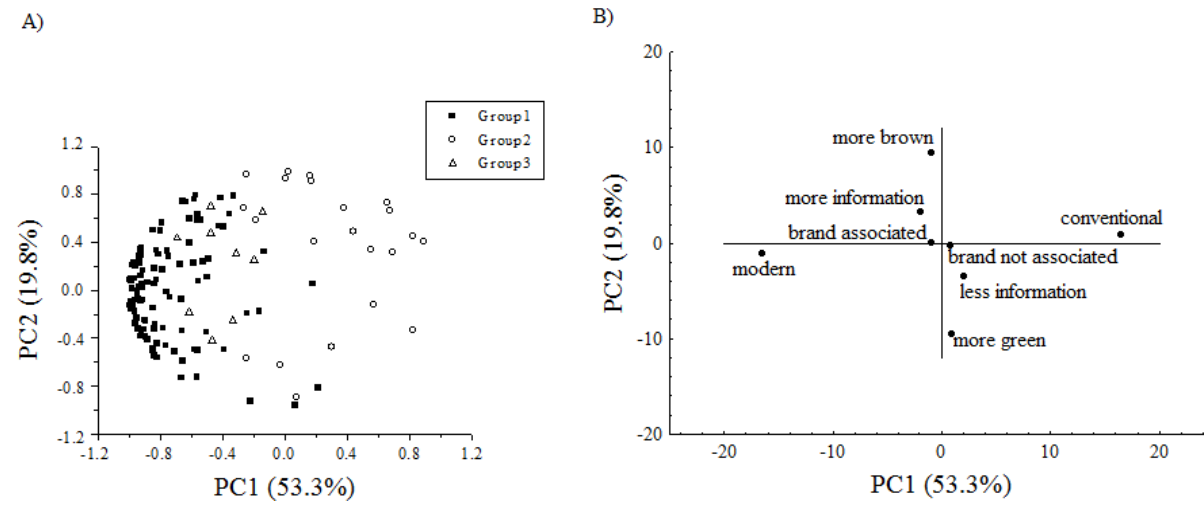
Figure 4. Principal component analysis considering the impact of the factors in purchase intent: ( A ) Scatter plot of the consumers identified by the groups; ( B ) Projection of the variables: shape, color, brand and amount of